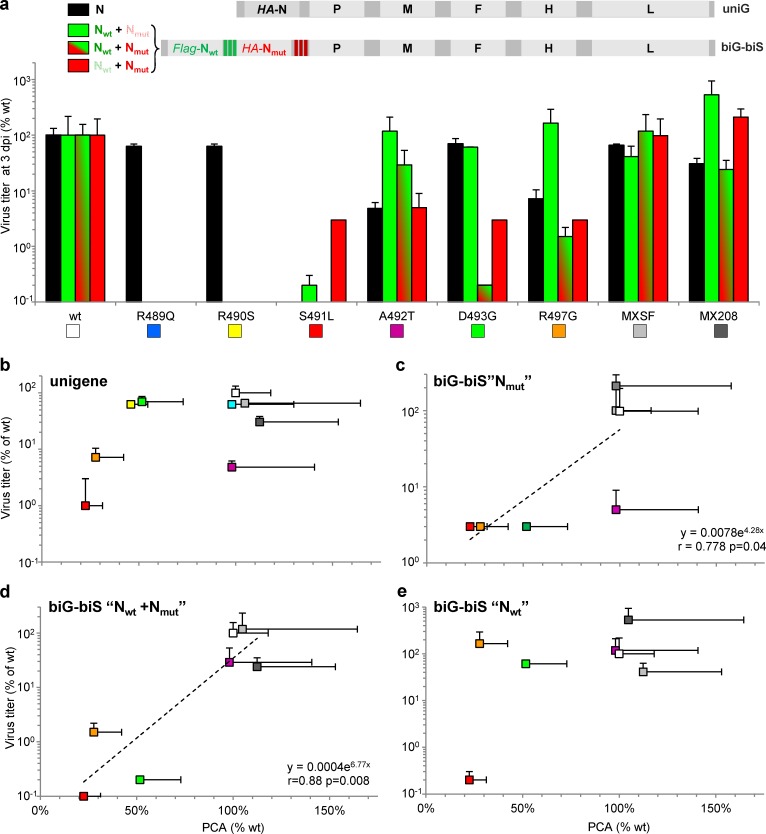
Virus production at 3 d.p.i. and in the context of unigene and biG-biS viruses and relationships with NTAIL/XD interaction strength.
(a) Infectious virus production after infection with recombinant virus coding for NTAIL variant (unigene virus) or biG-biS virus bearing two copies of the N gene, one coding for wt Flag-N1 and either wt or variant HA-N2 in conditions allowing selective expression of the wt Flag-N1 copy, wt or variant HA-N2 copy or both of them (data expressed in % of wt, mean ± SD). Although all biG-biS viruses were successfully rescued, R489Q, R490S and S491L could not be further studied because of a too low virus production. (b-e) Virus titers expressed in % of wt virus (for unigene viruses) or wt Flag-N1/wt HA-N2 (for biG-biS viruses) were plotted (mean ± SD) against NTAIL/XD binding strength as determined by glu-PCA (mean ± SD). Panel b shows virus production from unigene N variants. Virus production from biG-biS viruses with (c) selective expression of variant HA-N2 copy, or (d) simultaneous expression of wt Flag-N1 and variant HA-N2 copies, or (e) selective expression of the wt Flag-N1 copy. Same color codes as in Fig 1B, see also panel a. Shown are means and SD as obtained from three independent infections. See also S8, S9 and S10 Figs.